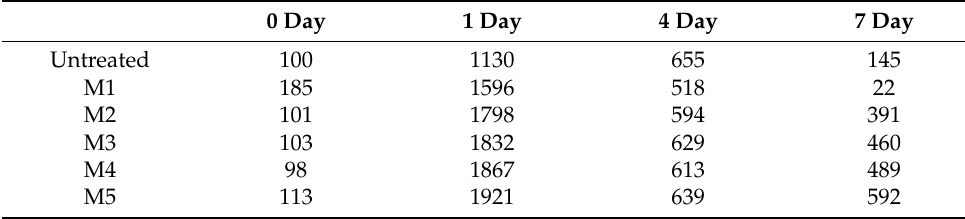
Table 4. TVFAs of food waste based on pretreatment conditions (unit: mg COD/L). 0 0 Day